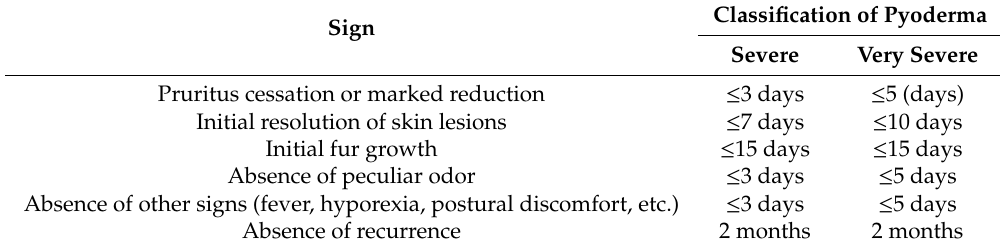
Table 1. Signs of positive response to treatment, and days in which they were expected to occur, in dogs with unresponsive canine deep pyoderma classified as severe to very severe. Dogs were treated orally with enro-C (10 mg / kg / day) plus an enro-C gel 0.5% applied topically on a ff ected areas thrice a day. Classification of Pyoderma Sign Severe Very Severe Pruritus cessation or marked reduction ≤ 3 days ≤ 5 (days) Initial resolution of skin lesions ≤ 7 days ≤ 10 days Initial fur growth ≤ 15 days ≤ 15 days Absence of peculiar odor ≤ 3 days ≤ 5 days Absence of other signs (fever, hyporexia, postural discomfort, etc.) ≤ 3 days ≤ 5 days Absence of recurrence 2 months 2